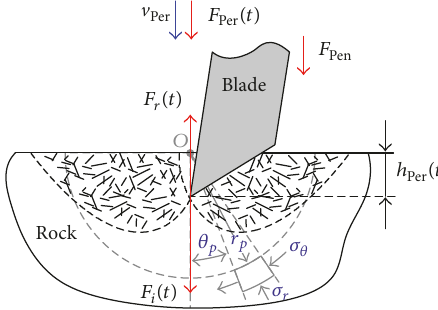
Figure 6: Stress analysis of the percussive fracture of lunar rock simulant via the cutting